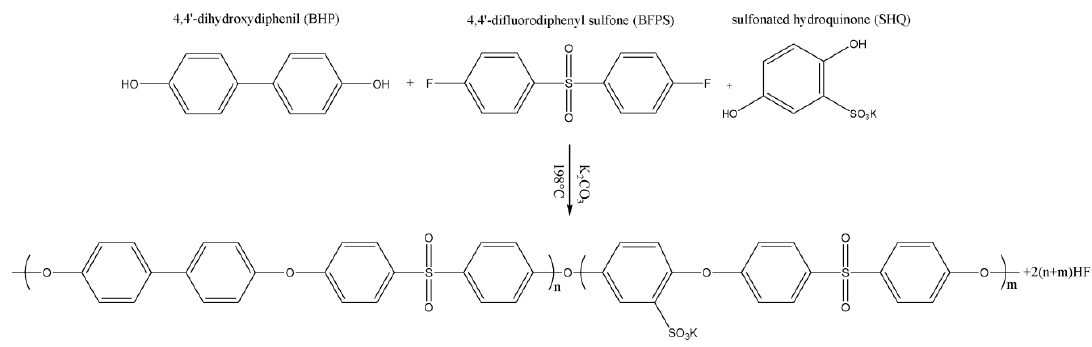
Figure 3. Synthesis route for SPAESs.